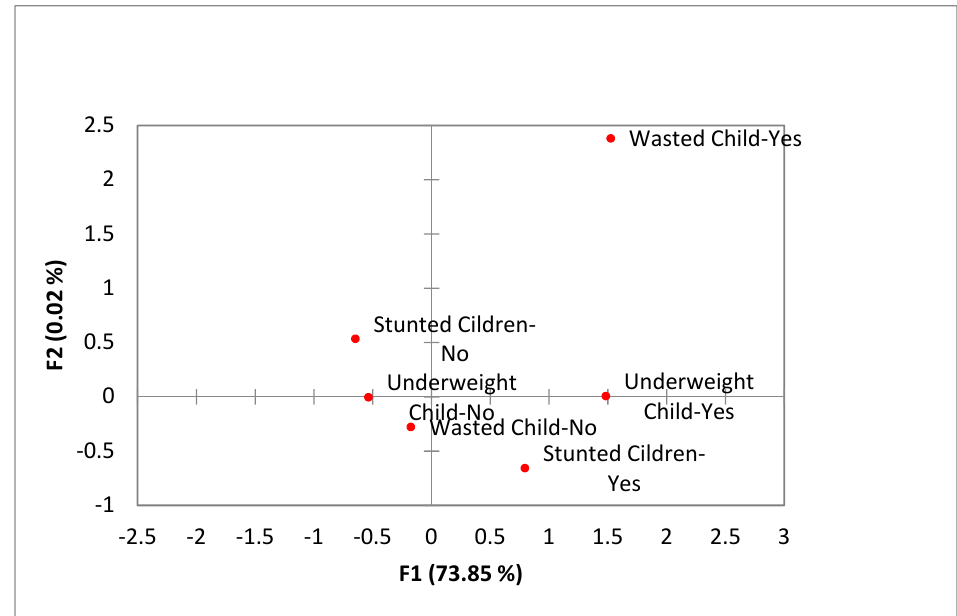
Figure 3. Multiple correspondence analyses of conventional measures (Stunting, wasting and underweight).